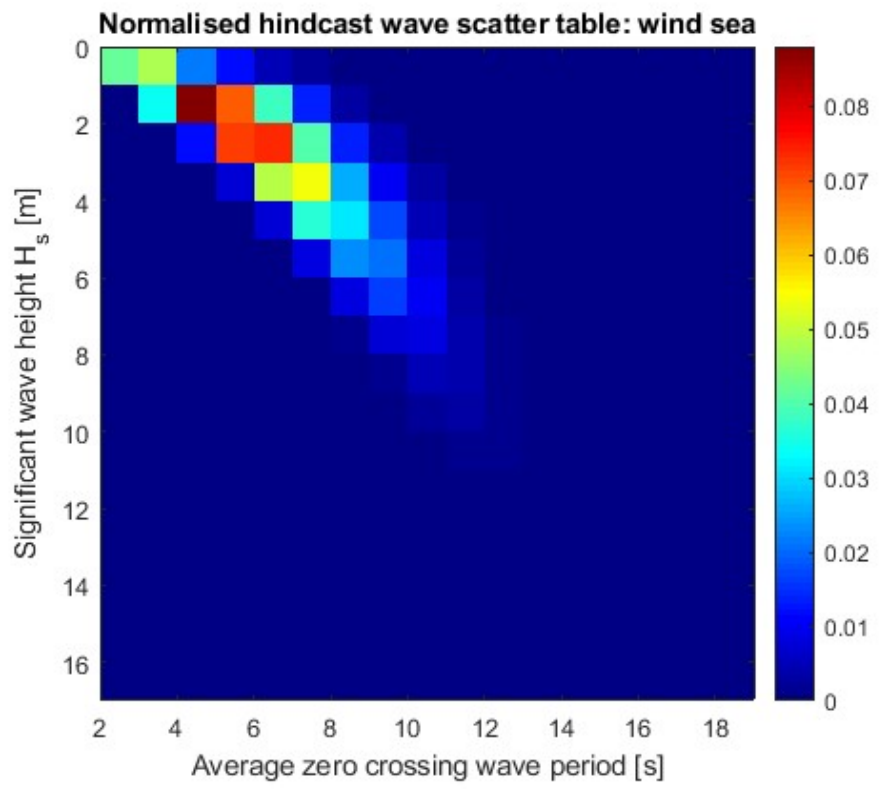
Figure 5. Hindcast WST for wind sea (sea area S—full year).